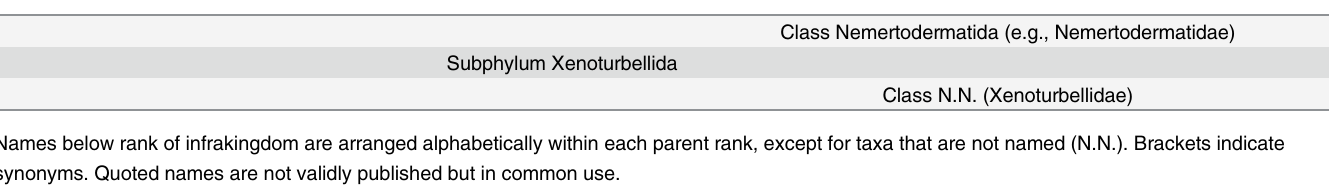
S1 Table. Proposed hierarchical classification from superkingdom to